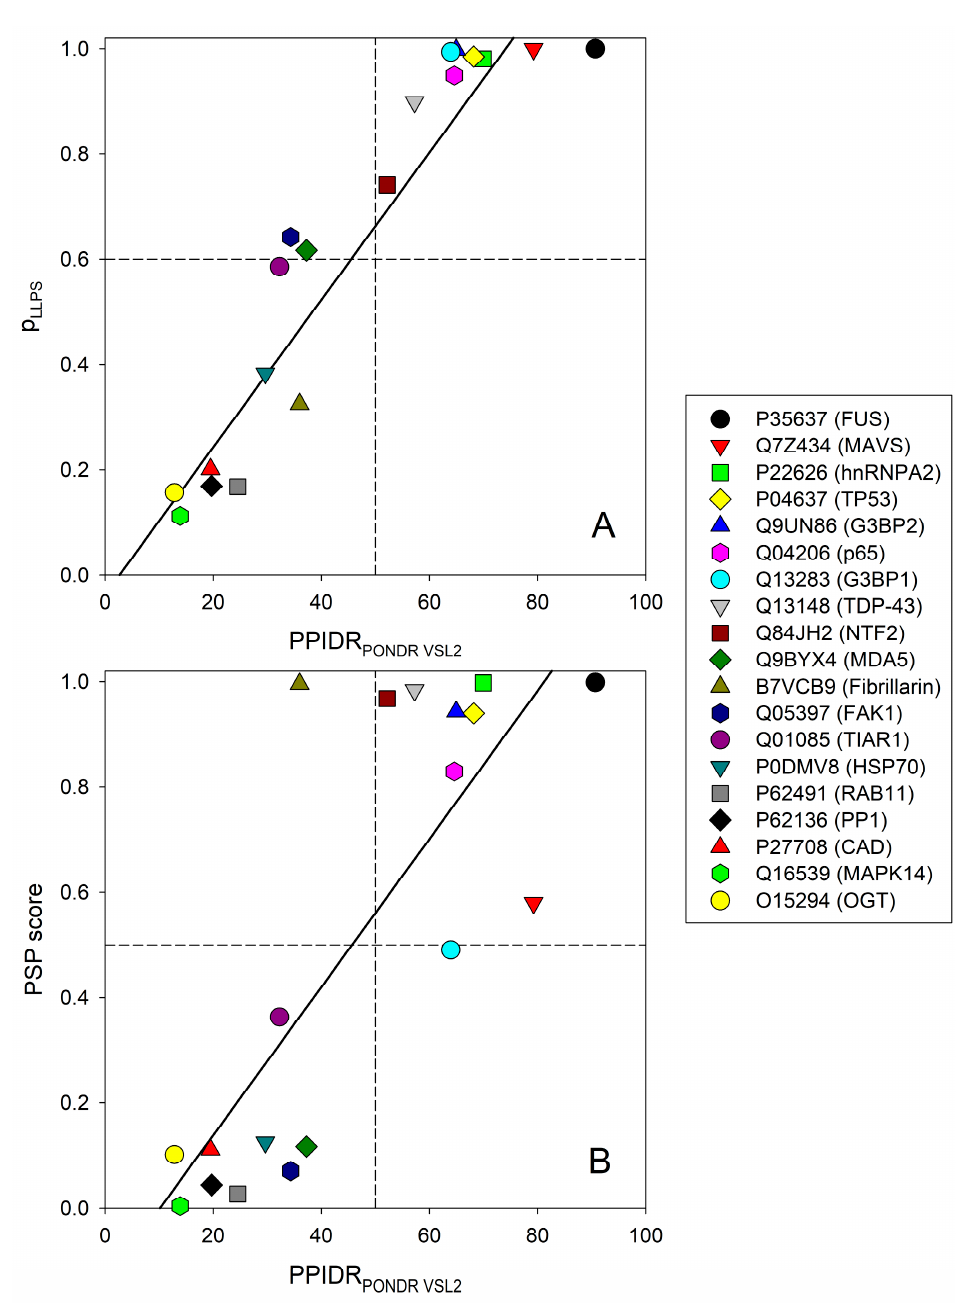
Figure 6. Correlations between protein intrinsic disorder content, PPIDR PONDR VSL2 , as evaluated by PONDR ® VSL2, and probability of spontaneous liquid–liquid phase separation, p LLPS , evaluated by FuzDrop ( A ) or phase separation protein score, PSP score, evaluated by PSPredictor ( B ).